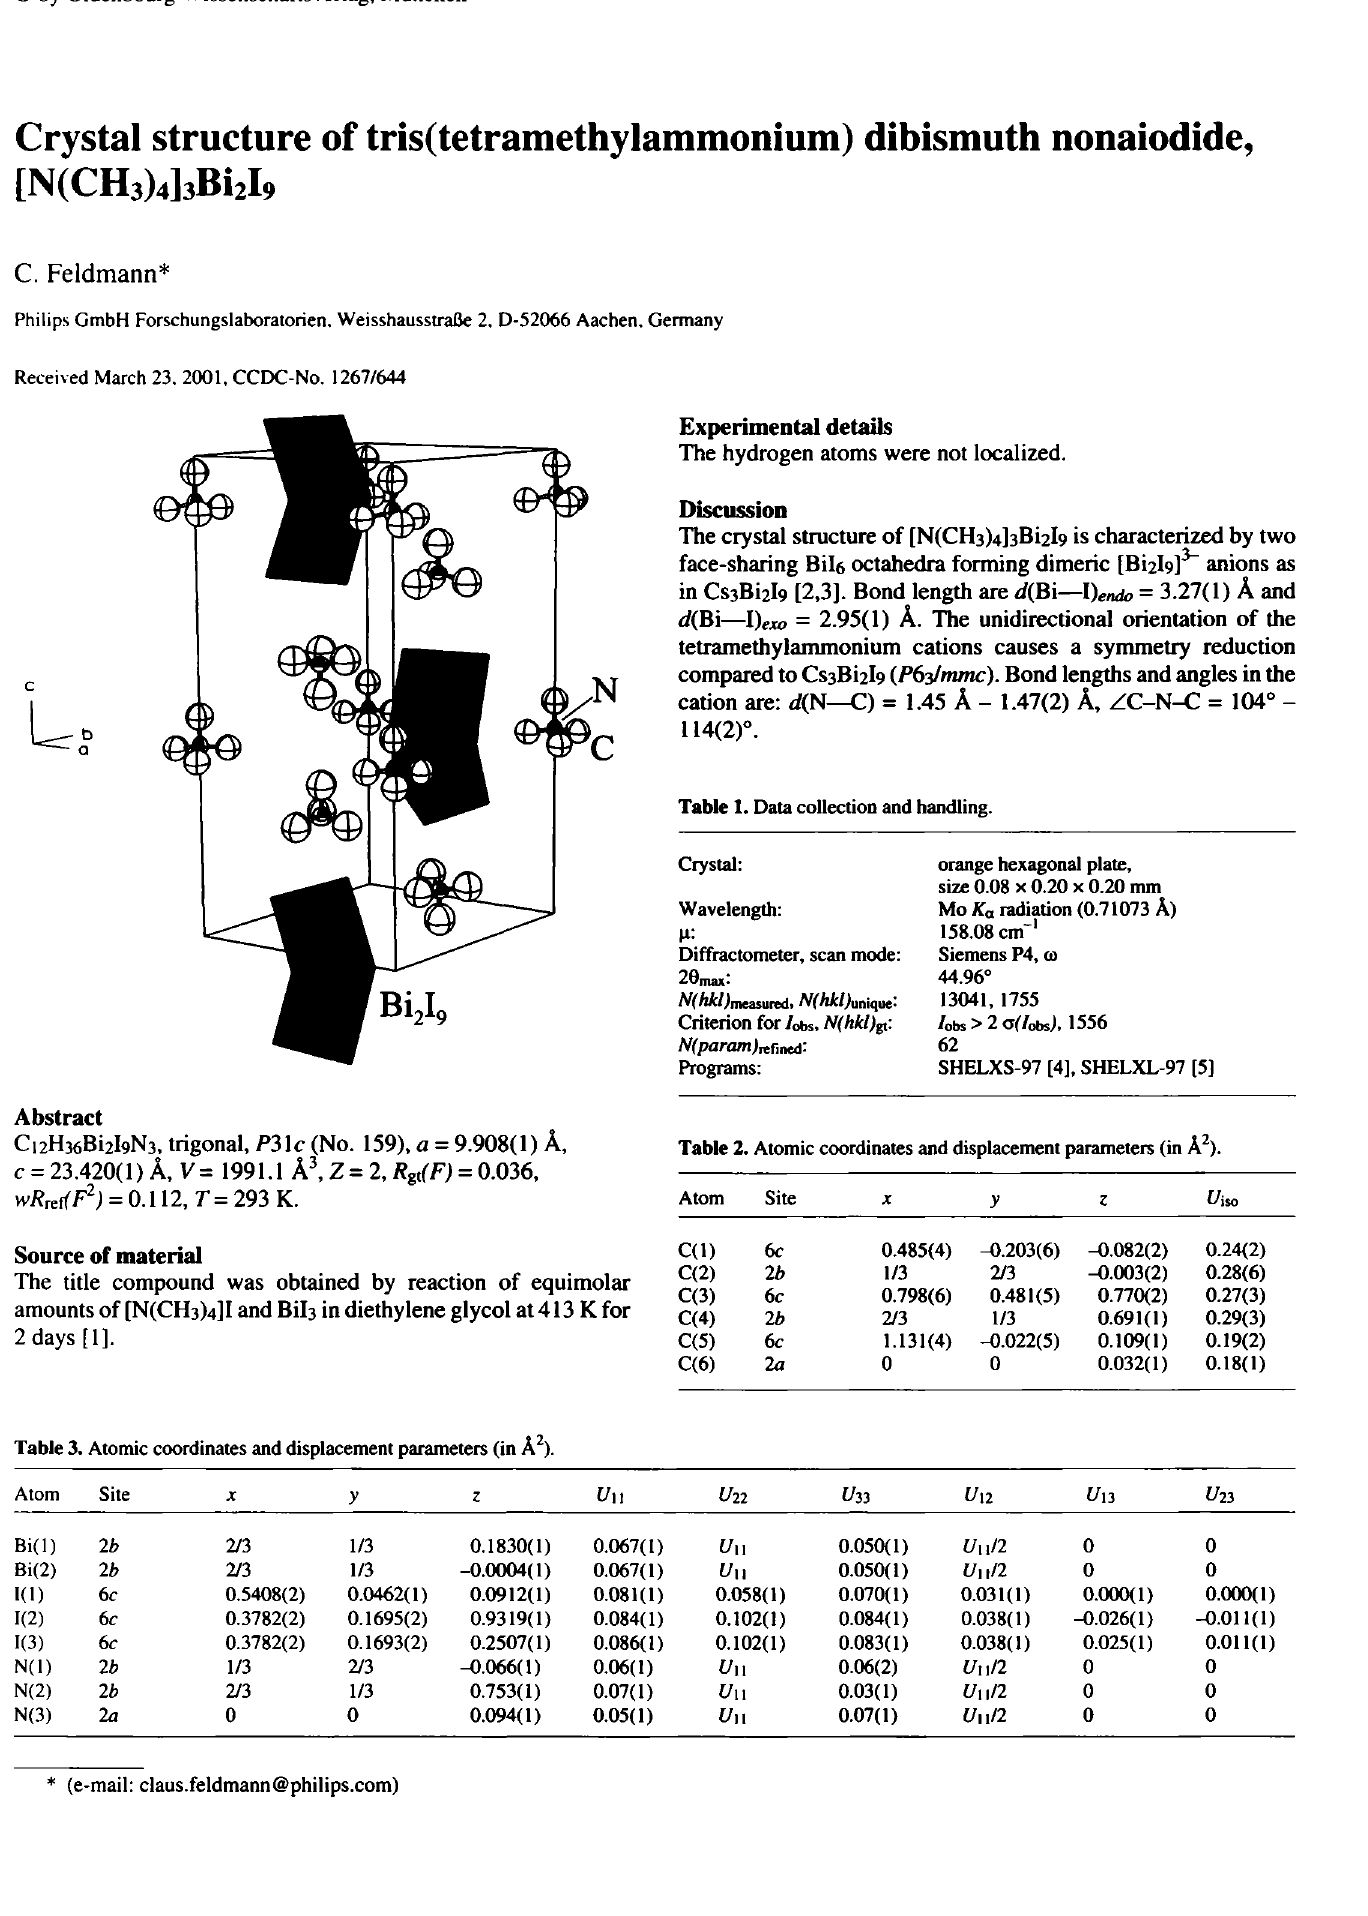
Table 2. Atomic coordinates and displacement parameters (in Ä 2 ).